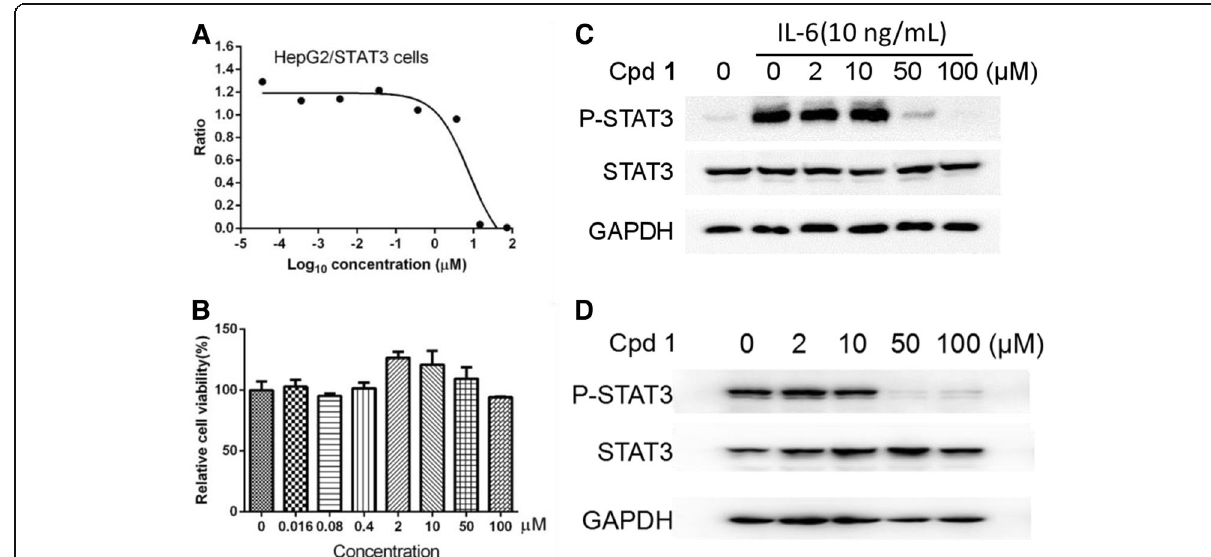
Fig. 2 2-Ethoxystypandrone (1) inhibited the IL-6-induced and constitutive activation of STAT3. a . Dose-dependent inhibition of 2- ethoxystypandrone (1) on the IL-6-induced STAT3 activity. HepG2/STAT3-luciferase cells were pretreated with 2-ethoxystypandrone (1) at indicated concentrations for 1 h, and the luciferase activity was measured following stimulation of IL-6 (10 ng/mL) for 5.5 h; b . HepG2/STAT3- luciferase cells were treated with indicated concentrations of 2-ethoxystypandrone (1) for 6.5 h. Cell viability was determined by MTT assay; c . Compound 2-Ethoxystypandrone (Cpd 1) inhibited the IL-6-induced phosphorylation of STAT3 in HepG2/STAT3-luciferase cells. HepG2/STAT3 luciferase cells were pre-treated with 2-ethoxystypandrone (1) at the indicated concentrations for 2 h and were then stimulated with 10 ng/mL interleukin-6 for 15 min and the cell lysates were prepared for Western Blot analysis using anti-phospho-STAT3 antibody; d . 2-Ethoxystypandrone (1) inhibited the basal constitutive activation of STAT3 in HepG2 cells. The HepG2 cell lysates were prepared for Westerm Blot after cells were pre- treated with 2-ethoxystypandrone (1) for 2 h and without IL-6